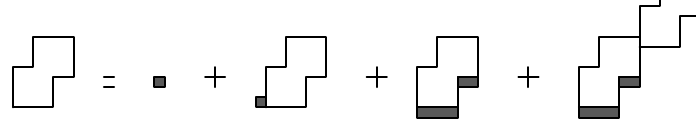
Fig. 5: Schematic object grammar for parallelogram